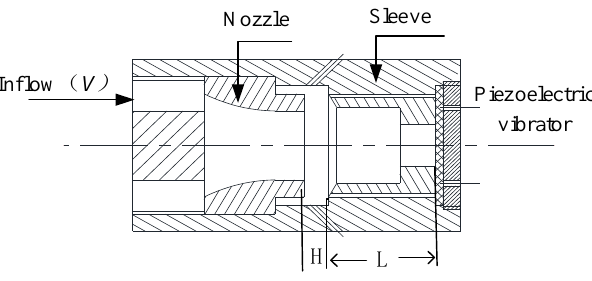
Figure 2. Structure diagram of the airflow-induced acoustic piezoelectric generator.